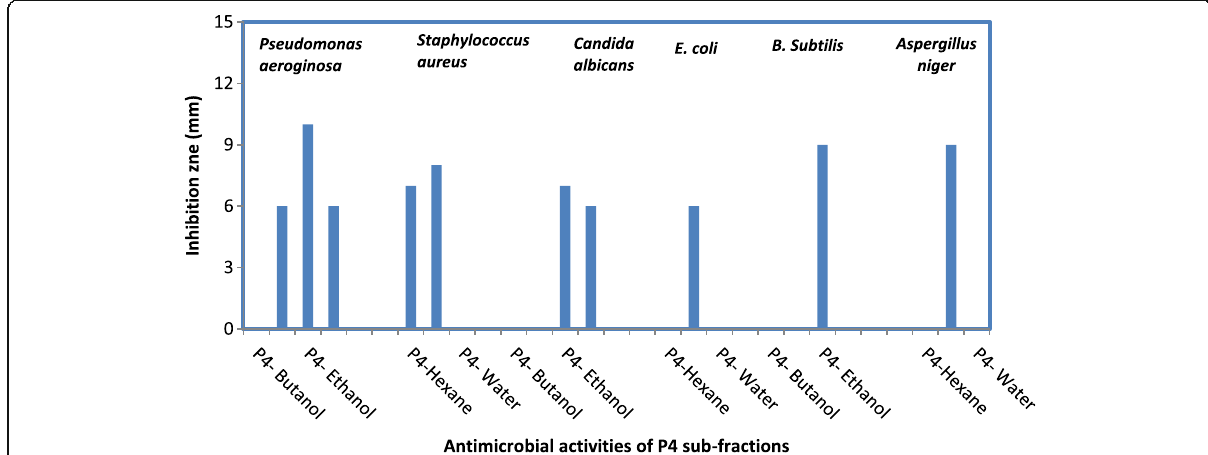
Fig. 4 Antimicrobial activity of subfractions from liquid-liquid partition using disc diffusion